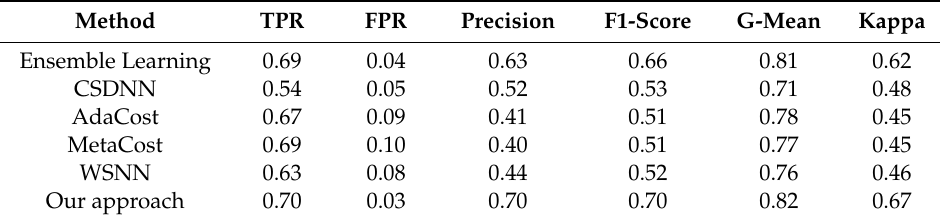
Table 5. Classification results of di ff erent class imbalance